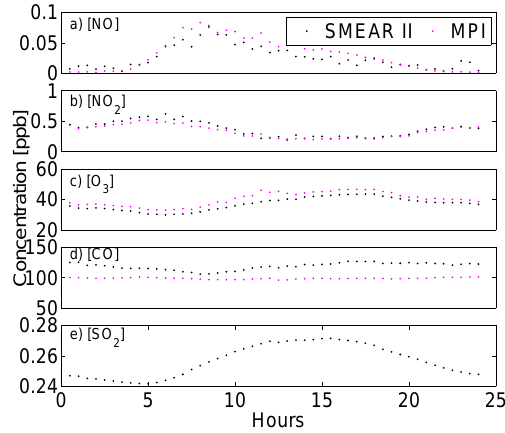
Figure 1. The daily averaged measured concentration of (a) NO, (b) NO 2 , (c) O 3 , (d) CO, and (e) SO 2 during the campaign. The SMEAR II mast data are shown in black, while the extra measure- ments by MPI are shown in